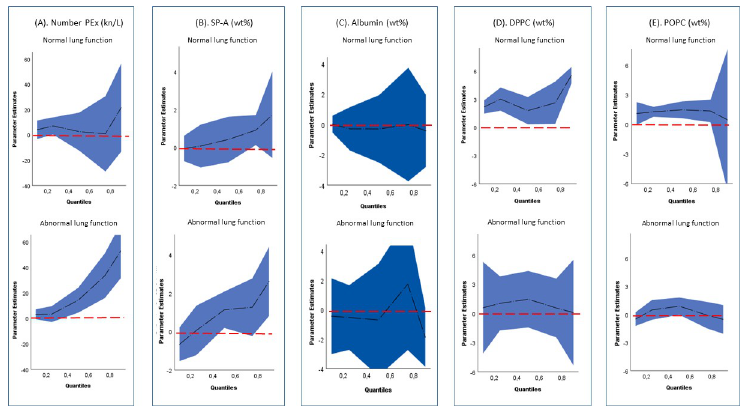
Fig 2. PEx-variables among current- compared to never-smokers at normal and abnormal lung function. Plots illustrating age- and sex-adjusted quantile regression estimates of current smokers to never smokers (the red dotted line), stratified on normal and abnormal lung function (n = 35 and n = 31, respectively). (A) number PEx (kn/L), (B) SP-A (wt%), (C) Albumin (wt%), (D) POPC (wt%) and (E) POPC (wt%) were analyzed separately, as were the sub- groups. Quantiles on x-axis refers to the distribution of the PEx-variable studied. Estimates from current smokers compared to never smokers presented at normal lung function (n = 19 and n = 16, respectively) and abnormal lung function (n = 18 and n = 13, respectively). Estimates from quantile regression denoted by black dotted line with blue confidence intervals.